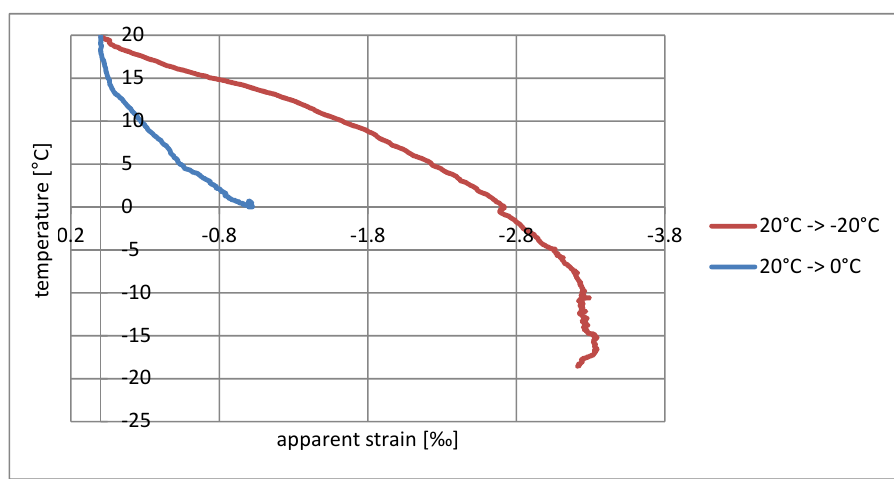
Figure 6. Dependence of apparent strain on rising temperature for the concrete sample.